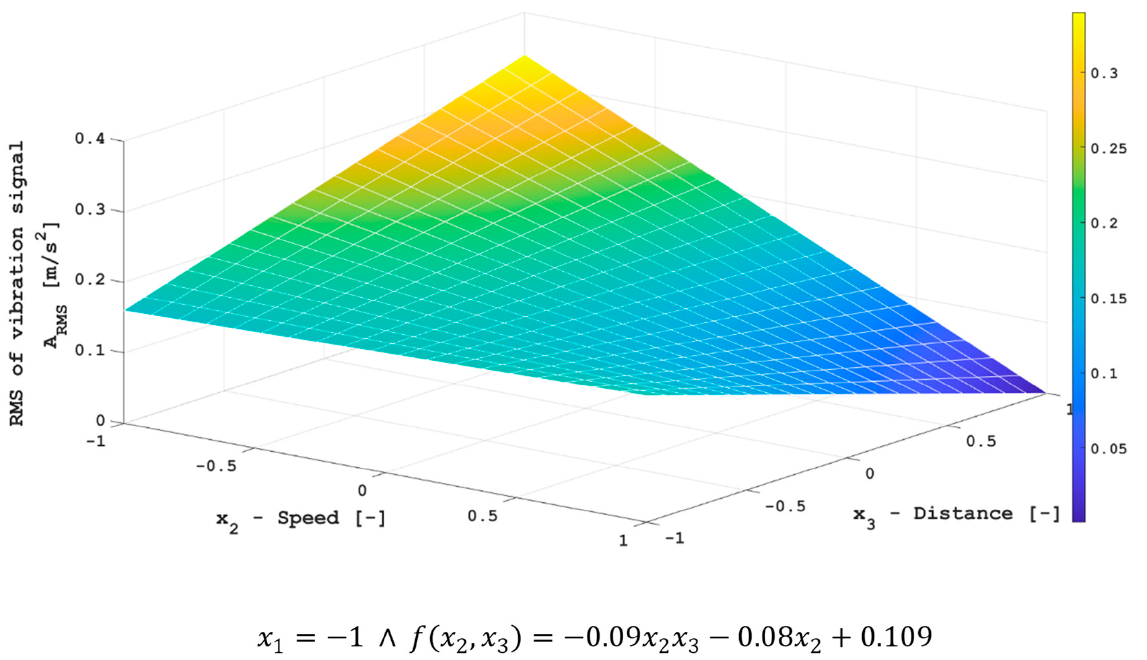
Figure 3. A RMS signal values, depending on the speed of the electric scooter and the distance traveled when moving on an asphalt road.